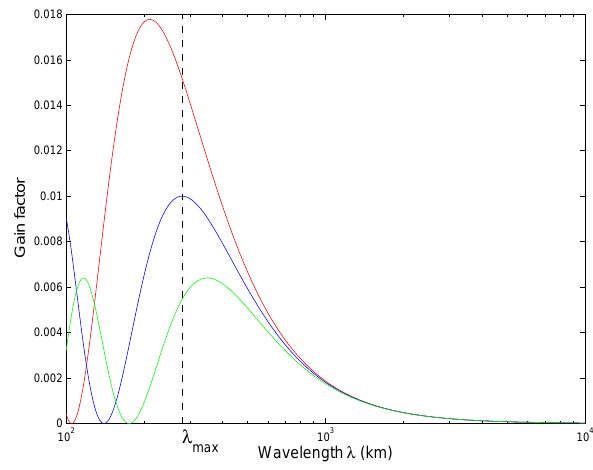
Fig. 1. Gain factor of the along-track second derivative as a function of the wavelength of the signal, using a step k = 15 s (red curve), k = 20 s (blue curve) and k = 25 s (green curve). The wavelength λ max ≈ 280 km associated with the maximum gain for k = 20 s is indicated on the graph.